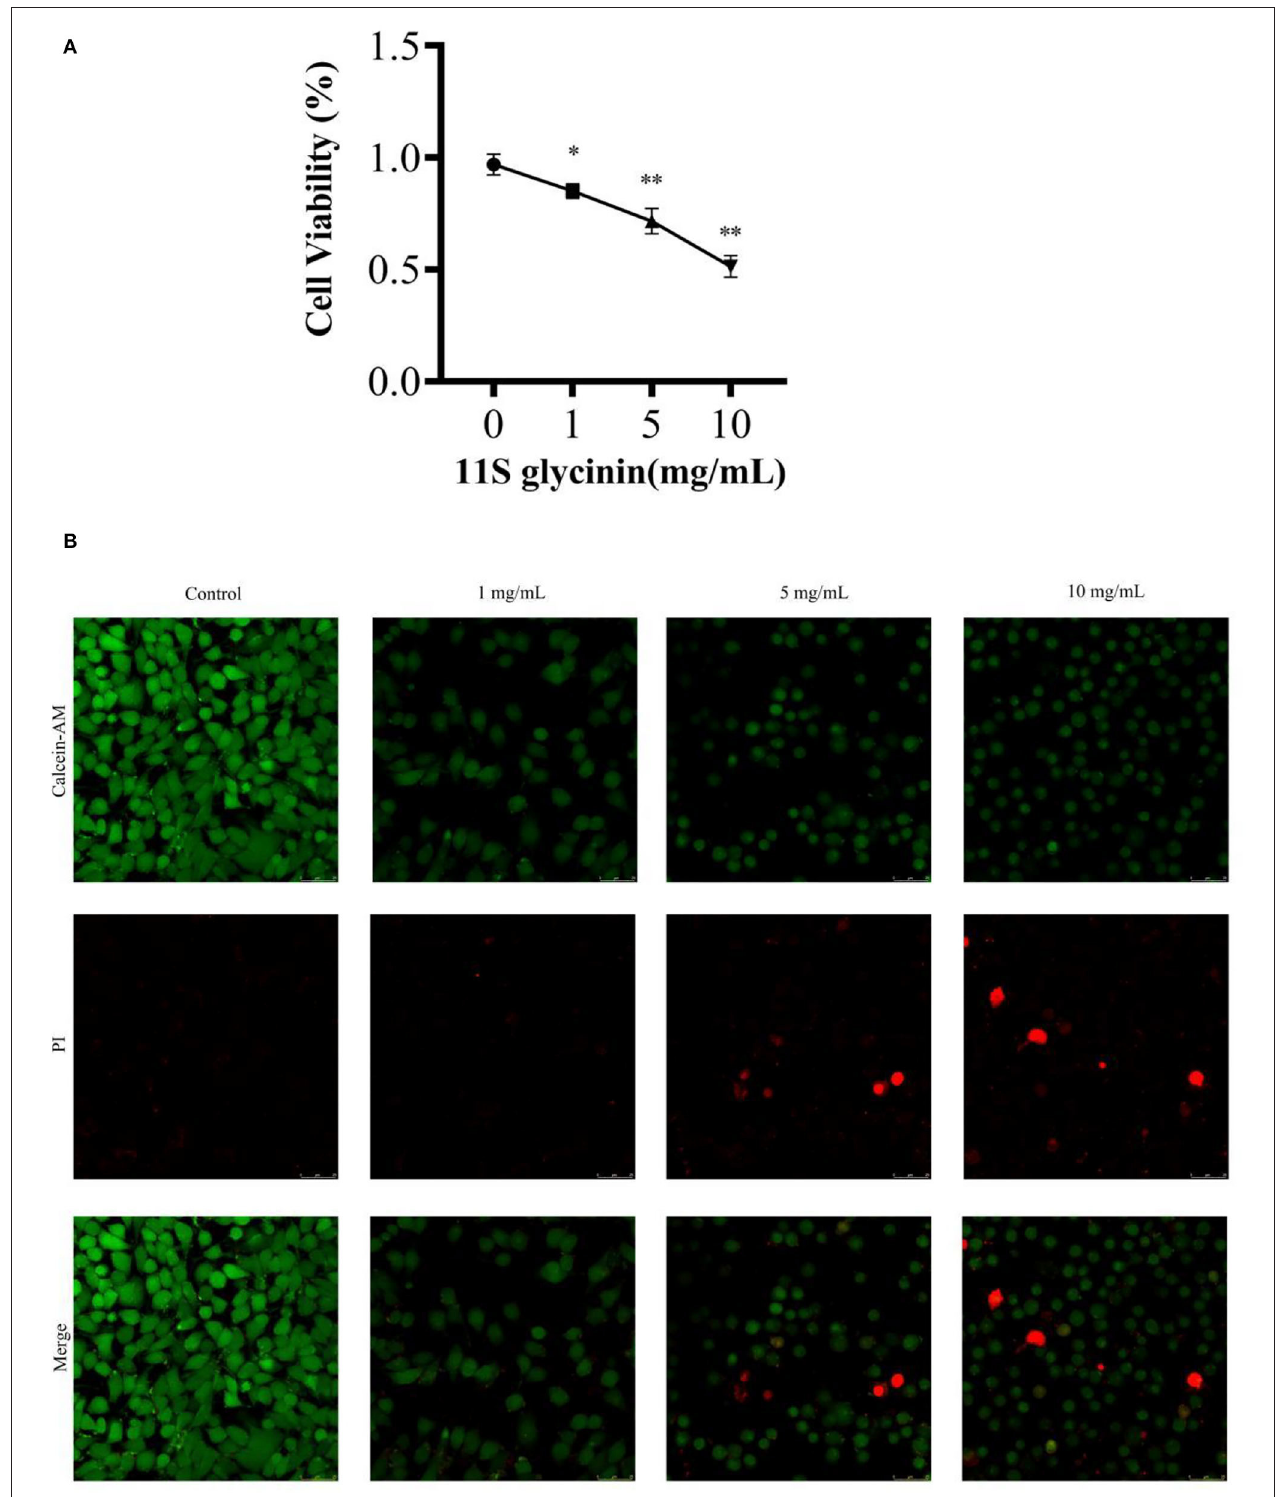
FIGURE 1 | 11S glycinin suppressed IPEC-J2 cells. (A) IPEC-J2 cells were stimulated with different concentrations (0, 1, 5, and 10 mg · ml − 1 ) of 11S glycinin for 24h, and cell viability was determined using the CCK-8 assay, n = 4. (B) Fluorescence photographs of IPEC-J2 cells stained by using the LIVE/DEAD TM kit. Data are shown as mean ± SD.* P < 0.05, ** P < 0.01, compared with the